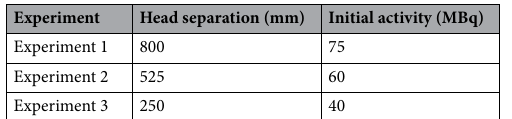
Table 1. Head separations and initial activities for each calibration experiment.